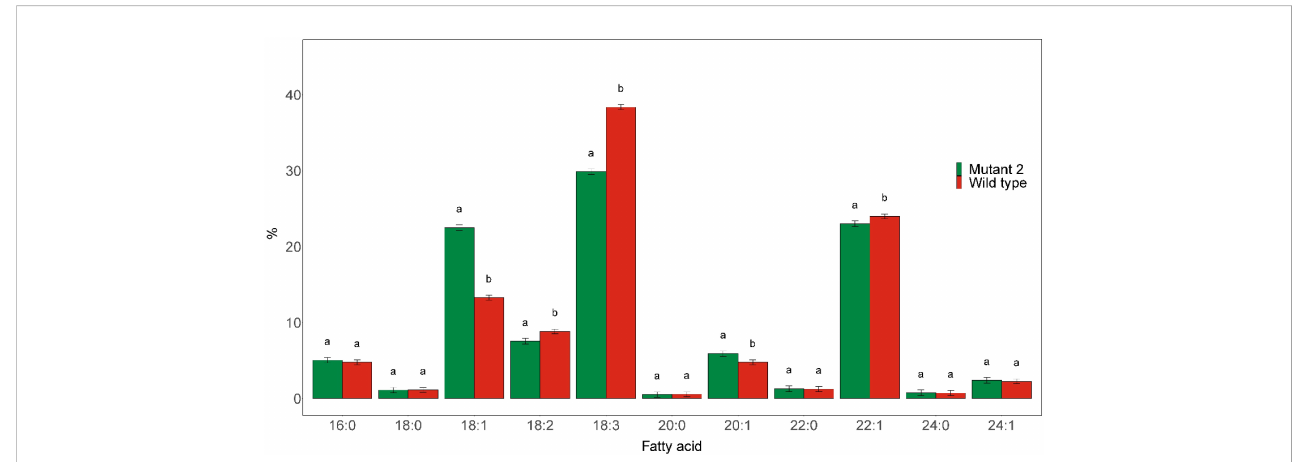
FIGURE 7 Major fatty acid compositions of seed oil derived from rod1 Mutant 2, as shown in Figure 2, and wild type. Different letters indicate statistically signi fi cant differences at p <0.05 ( n =